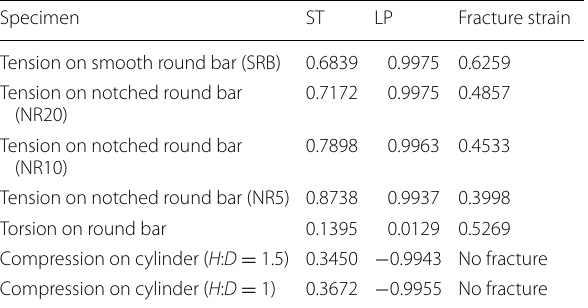
Table 3 ST, LP, and fracture strain of AA6063-T6 for